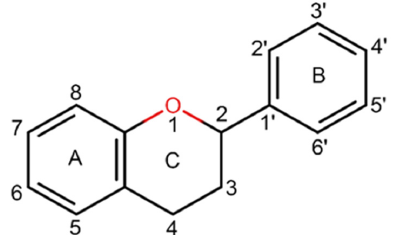
Figure 3. Three-ring structure of flavonoids. (A) The A ring is biosynthesized by the condensation of three moles of malonyl-coenzyme A (CoA) derived from the metabolism of glucose. The C and B rings were also derived from glucose metabolism via the shikimic acid pathway to yield cinnamic acid and its reduced product, coumaric acid (adapted from Formica & Regelson, 1995), (PubChem). An example of flavonoid is presented for each group.